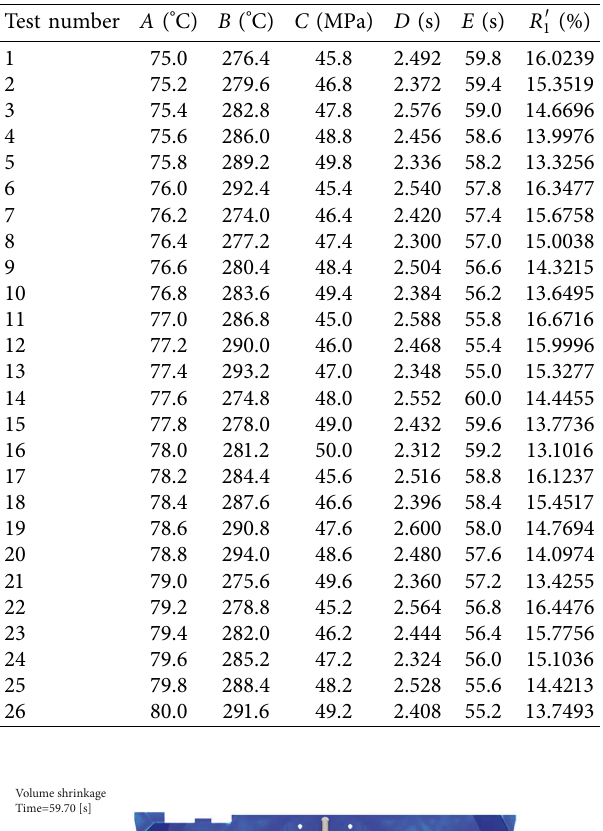
Table 12: Volume shrinkage prediction table.